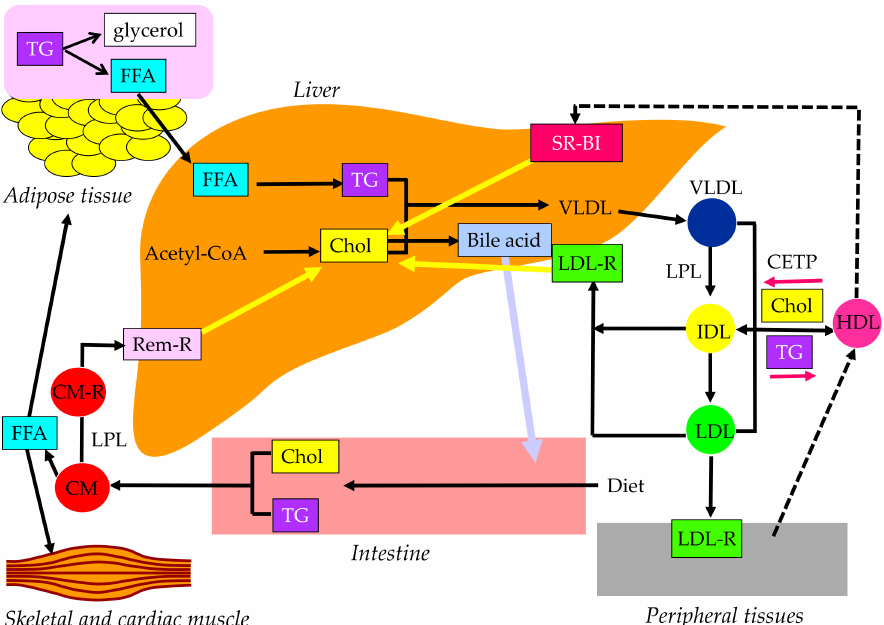
Figure 2. Metabolism of lipoproteins. CETP, cholesterol ester transfer protein; CM, chylomicron; CM-R, chylomicron receptor; Chol, cholesterol; FFA, free fatty acid; HDL, high-density lipoprotein; IDL, intermediate-density lipoprotein; LDL, low-density lipoprotein; LDL-R, low-density lipopro- tein receptor; LPL, lipoprotein lipase; Rem-R, remnant receptor; SR-BI, scavenge receptor BI; TG, triglyceride; VLDL, very-low-density